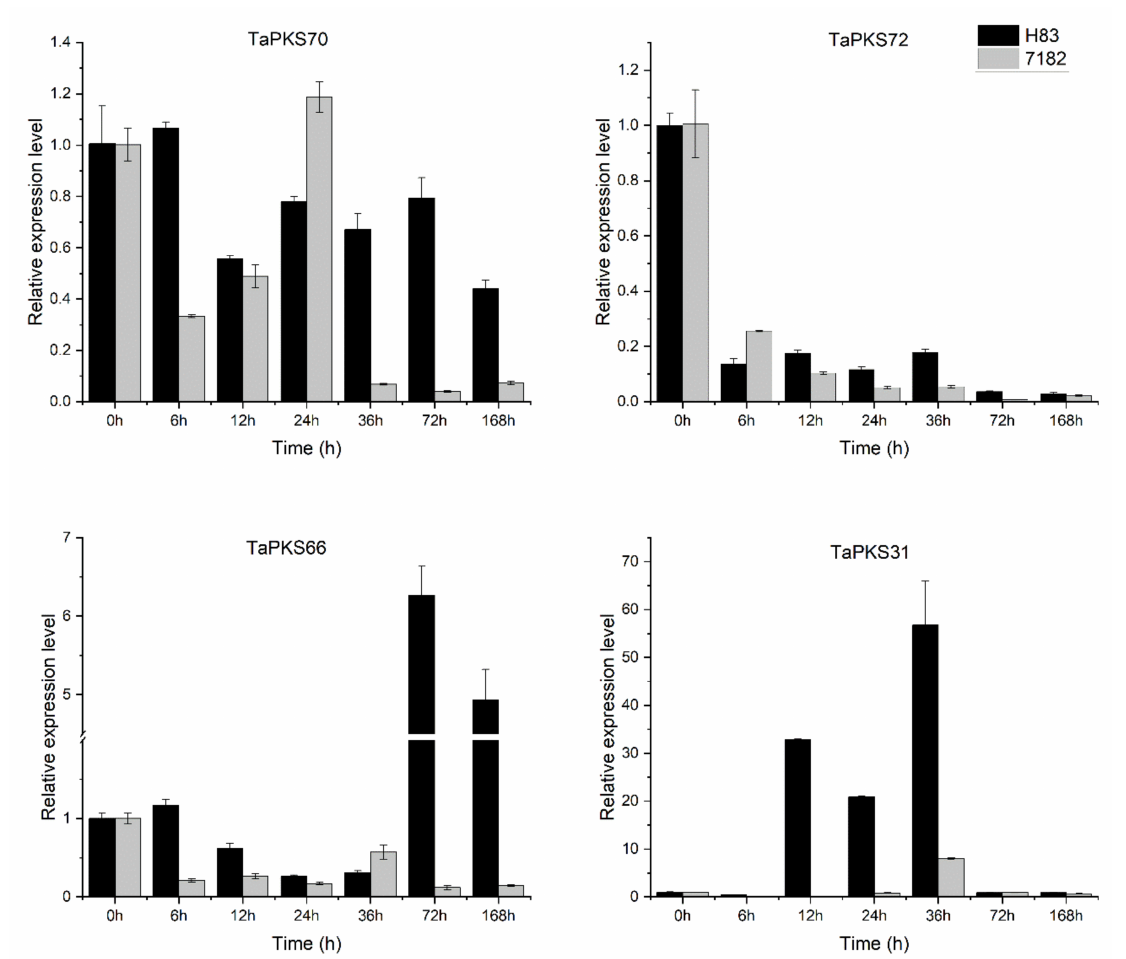
Figure 10. Expression analysis for four TaPKS genes in resistant wheat (H83) and susceptible wheat (7182) at different times after inoculation with Rhizoctonia cerealis . The average expression values were calculated based on three independent replicates. The error bars on the columns represent standard